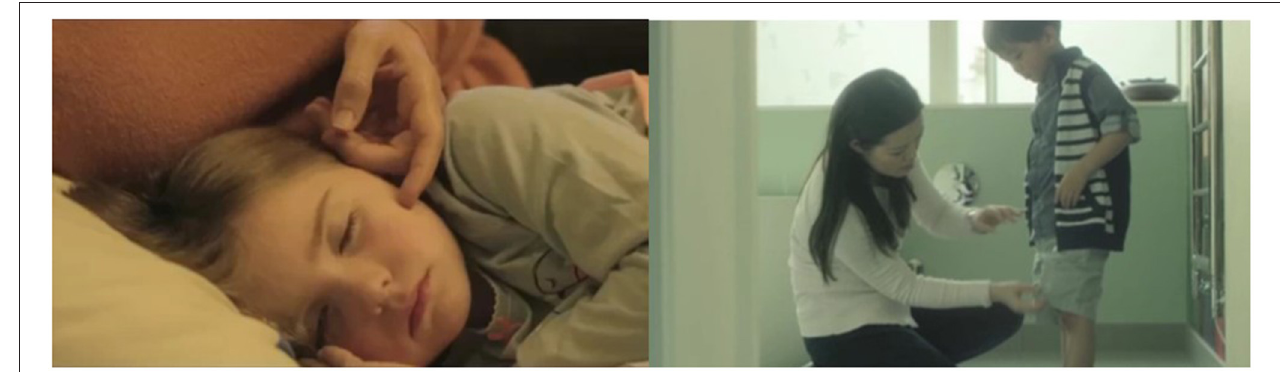
FIGURE 1 | Unicef Spot A—Two key frames of the spot based on historical memory. Source: Youtube Unicef Italia (2016).